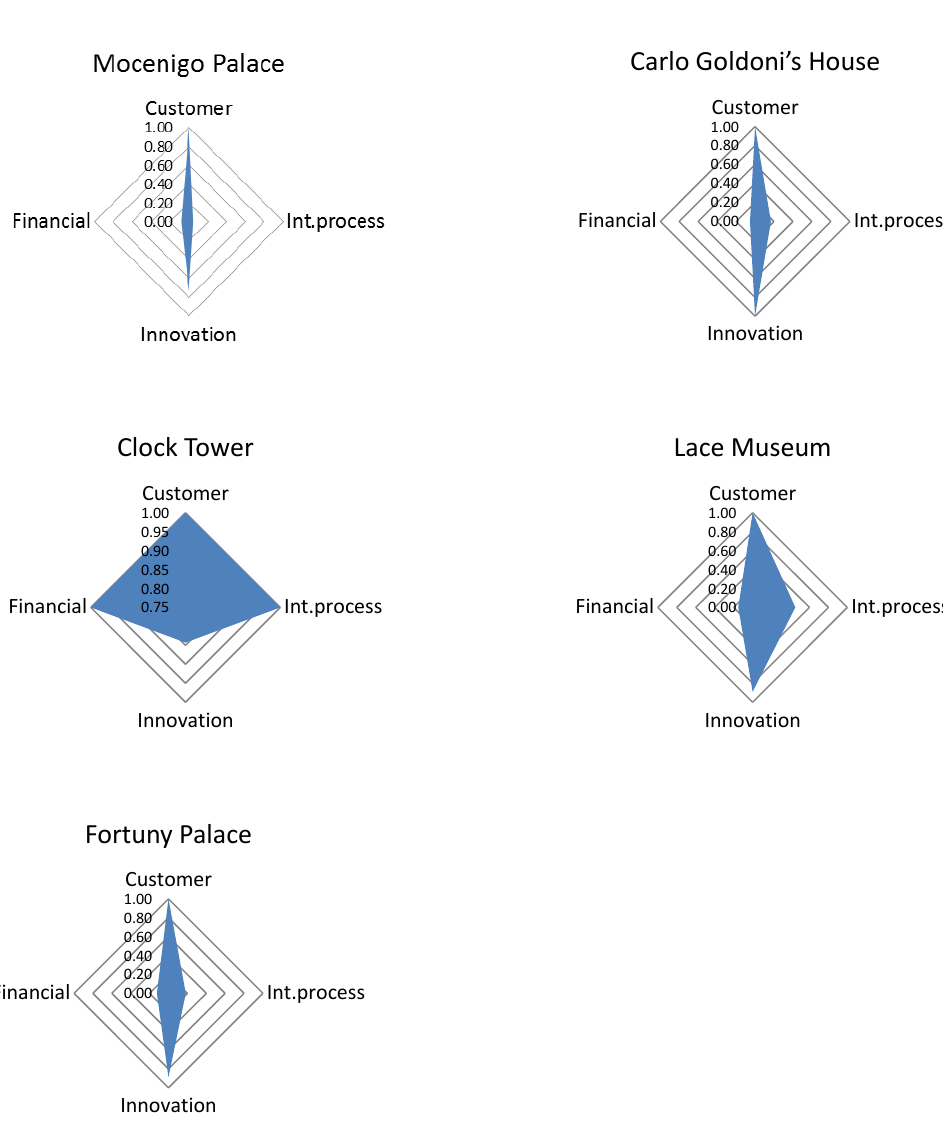
Figure 9. Radar charts showing for each museum the first stage DEA-BSC efficiency score of a different perspective along each of the four